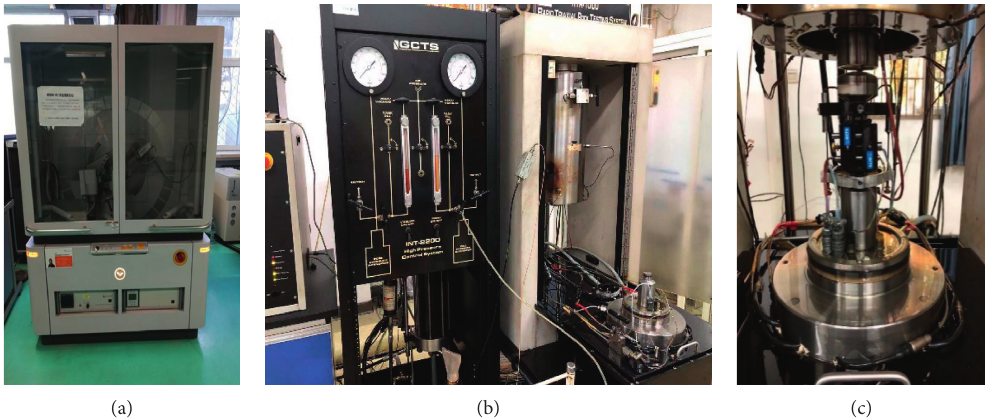
Figure 3: Experimental apparatus for sandstone tensile, compressive and mineral components. (a) Malvern Panalytical XRD. (b) Pressure test machine. (c) Rock sample installation.